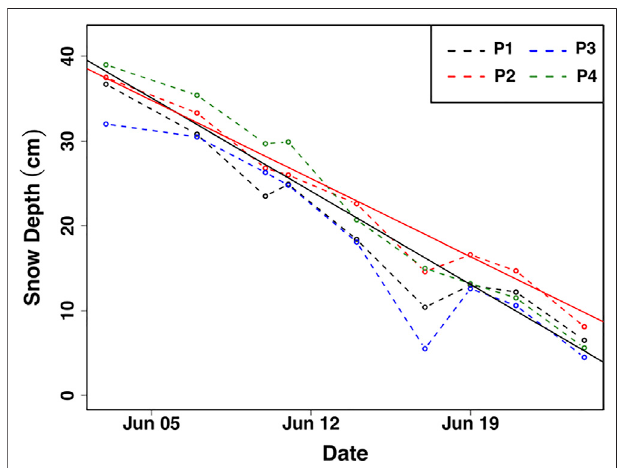
FIGURE 3 | Representative surface ablation measurements from quadrant fi ve during the sampling period. Average ablation rates of ~1.6 and ~1.5 cm day − 1 from quadrant 5 (black solid line) and from all 25 steaks (red solid line),respectively,are givenasbest fi tlinearregression lines.P1 — 4 represent the four ablation poles comprising Quadrant fi